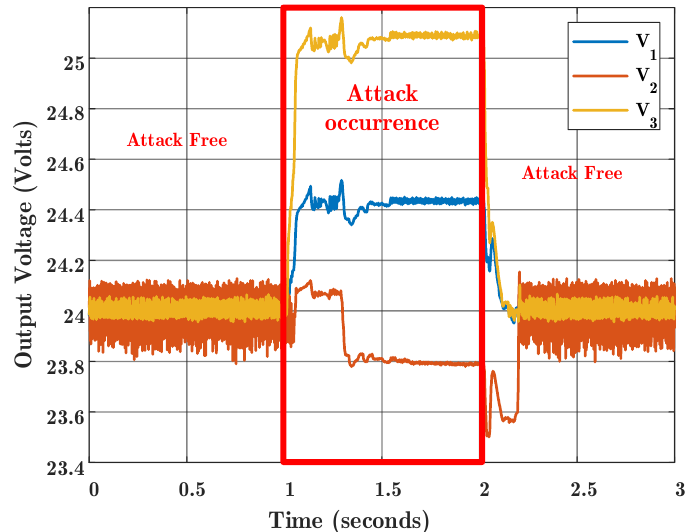
Figure 9. Experimental results for conventional consensus algorithm. FDI attack occurred at time 1 s and was removed at time 2 s.